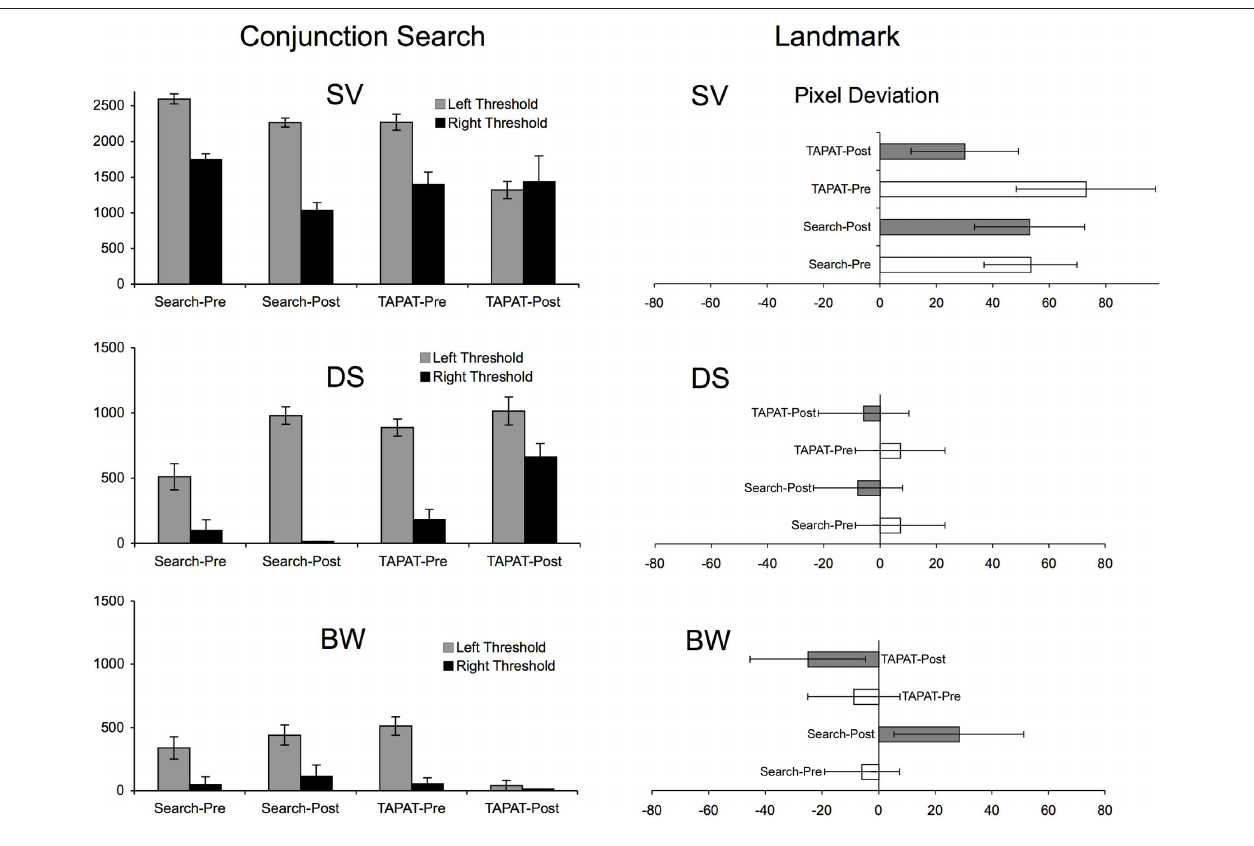
for patients to correctly identify it 75% of the time. This was calculated separately for right and left targets. For the landmark task, pixel deviation was collapsed across right starting and left starting trials to give an average pixel deviation to the right (positive values) or left (negative